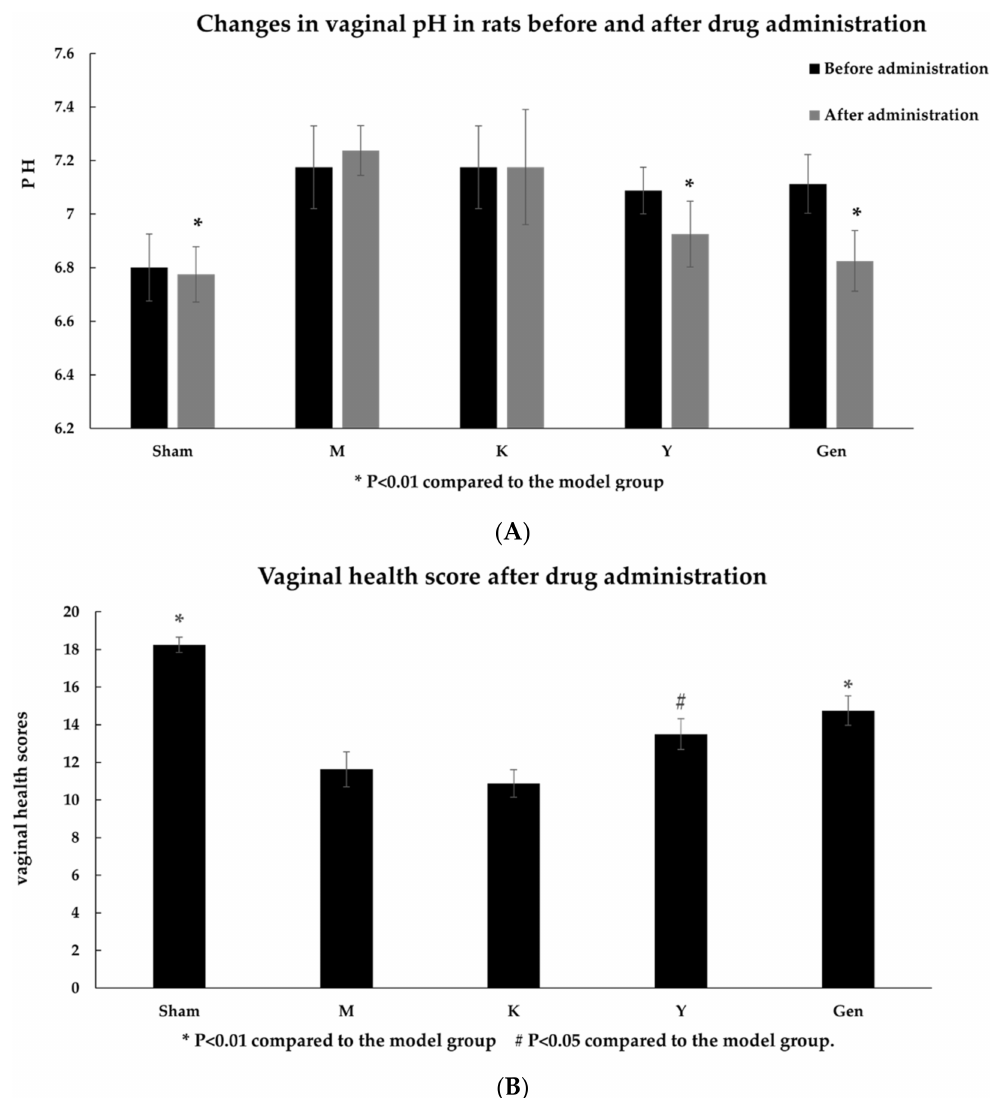
Figure 1. ( A ) Changes in vaginal pH in rats before and after drug administration; ( B ) Vaginal health score after drug administration. * p < 0.01 compared to the model group. # p < 0.05 compared to the model